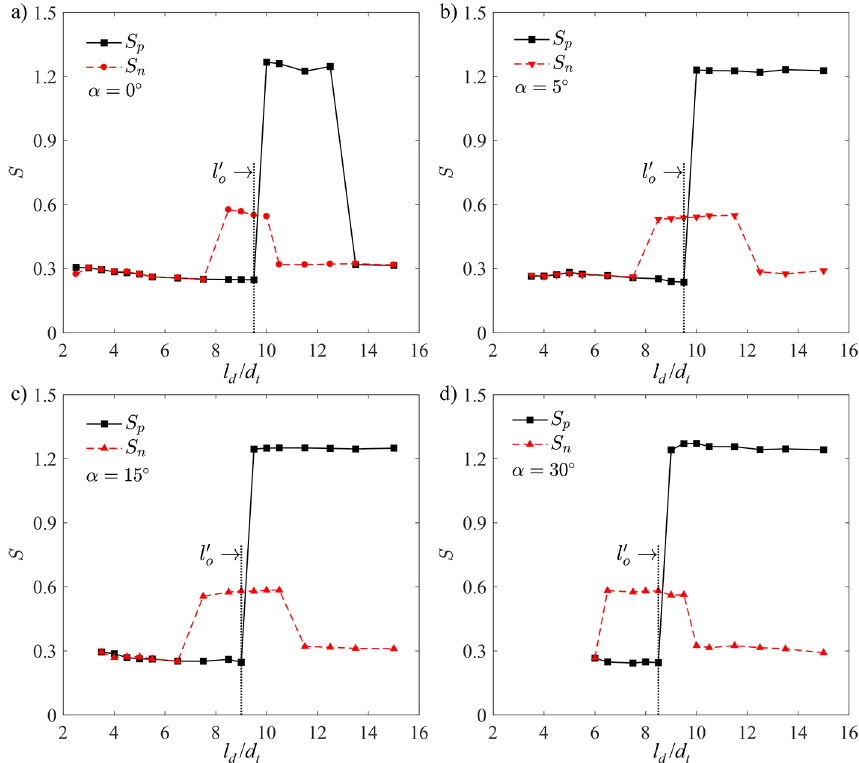
Figure 15. Normalized dominating frequencies (S) of the upstream pressure oscillations and the cavitation noise. ( a ) α = 0 ◦ ; ( b ) α = 5 ◦ ; ( c ) α = 15 ◦ ; ( d ) α = 30 ◦